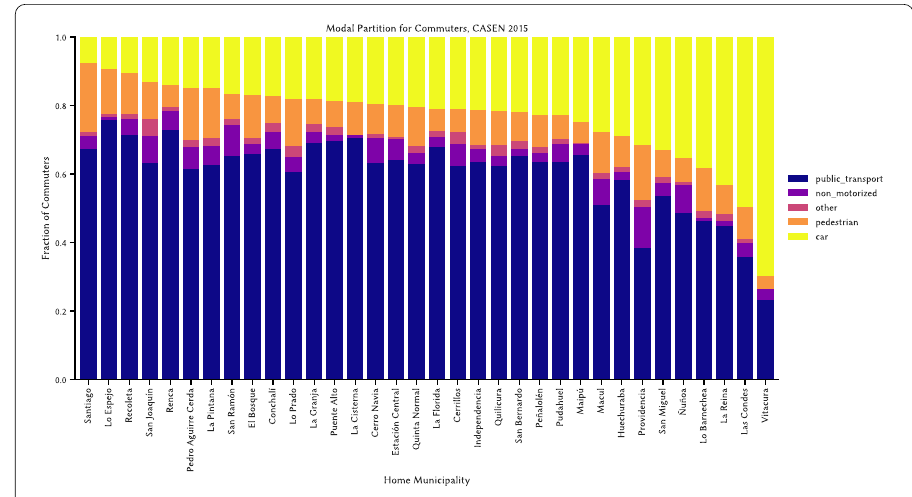
Figure 3 Relative distribution of mode of transportation usage ( modalpartition ) per home municipality in Santiago, according to the CASEN survey. The municipalities are sorted with respect to car usage. The public transport category contains buses, metro, and the connections between both modes